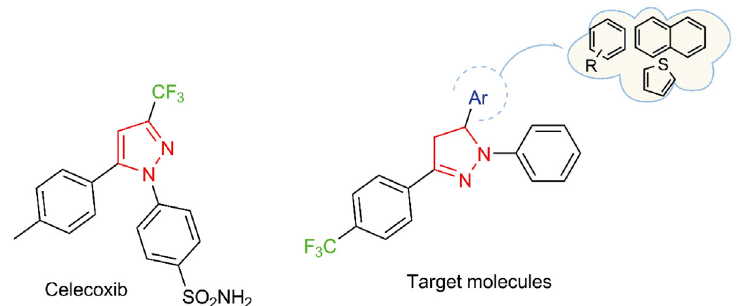
Figure 1. Chemical structure of designed compounds and